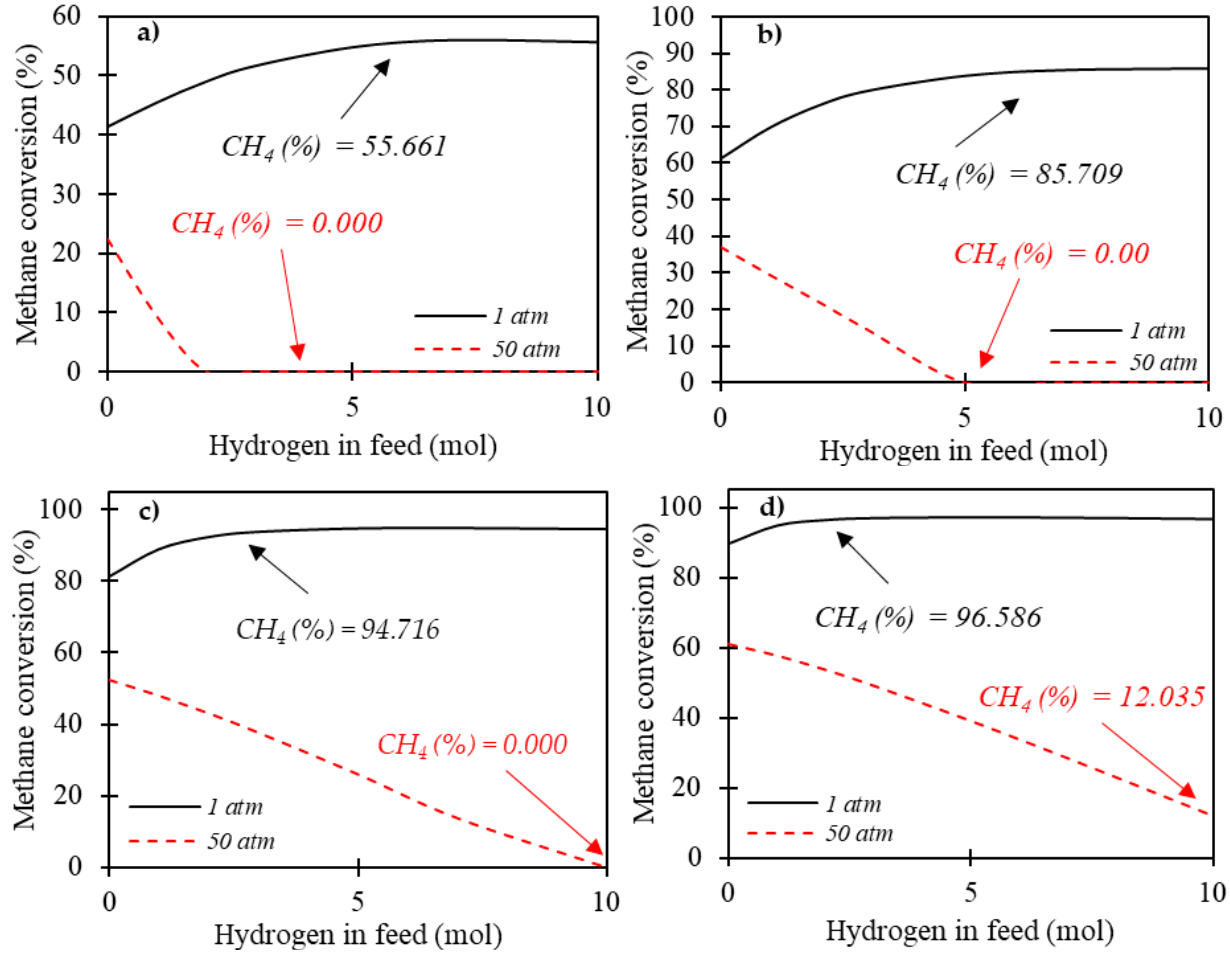
Figure 12. Combined effects of hydrogen addition, temperature, and pressure on methane conver- sions throughout the process (( a ): 1200 K, ( b ): 1400 K, ( c ): 1600 K, ( d ): 1800 K).